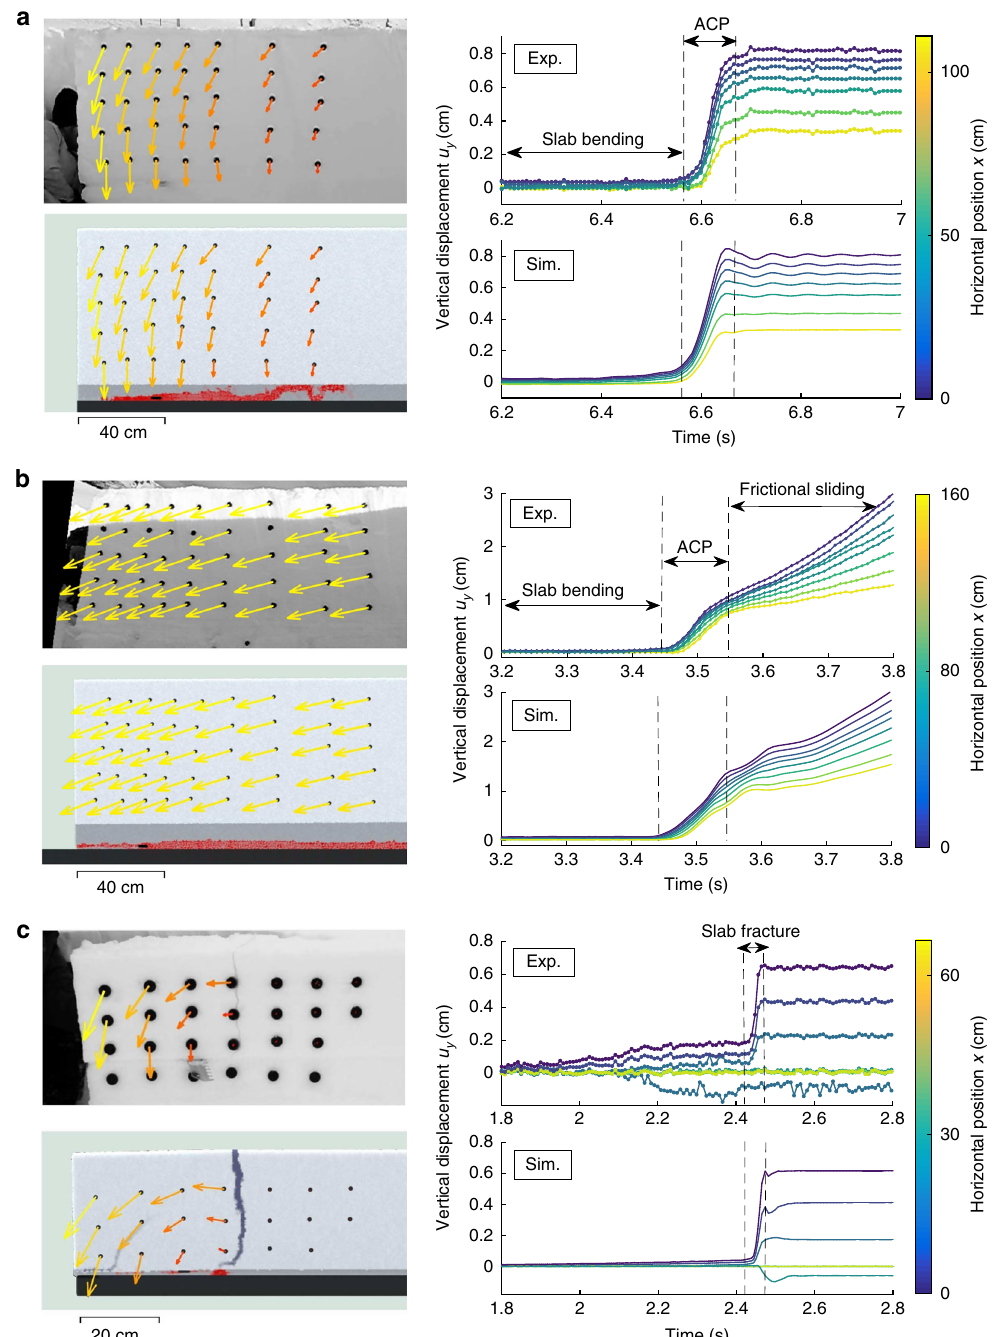
Fig. 2 Comparison between experimental and simulated results. Experimental (top) and numerical (bottom) results for experiment number 1 ( a ), experiment number 2 ( b ), and experiment number 3 ( c ). The displacement fi eld is shown on the left for different key instants in each case: during anticrack propagation ( t = 6.65 s) in a ; during frictional sliding ( t = 3.7 s) in b , and after slab fracture ( t = 2.5 s) in c . On the right, the time evolution of the average vertical displacement of vertical rows of markers is shown. The color represent the average horizontal position of each vertical row of markers. ACP anticrack propagation. The red color in the weak layer represents